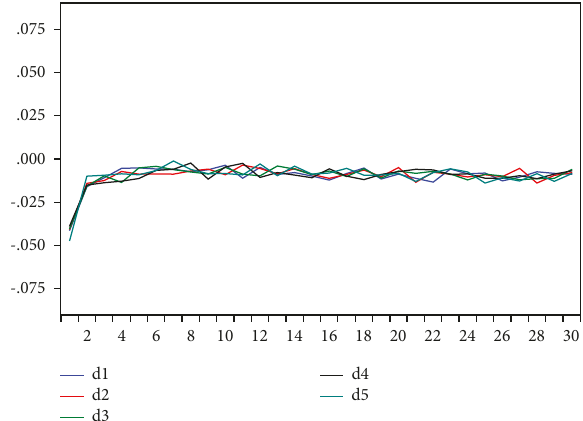
Figure 1: Autocorrelation of returns in the rational scenario. This figure plots the autocorrelation of returns in the rational scenario. In the simulations, we use the parameters from Zhu et al. [35] and Amilon [82]. d is the strength regarding the behavioral hesitation and decision rigidity of the anxious agent. The length of the lag extends from 1 to 30.